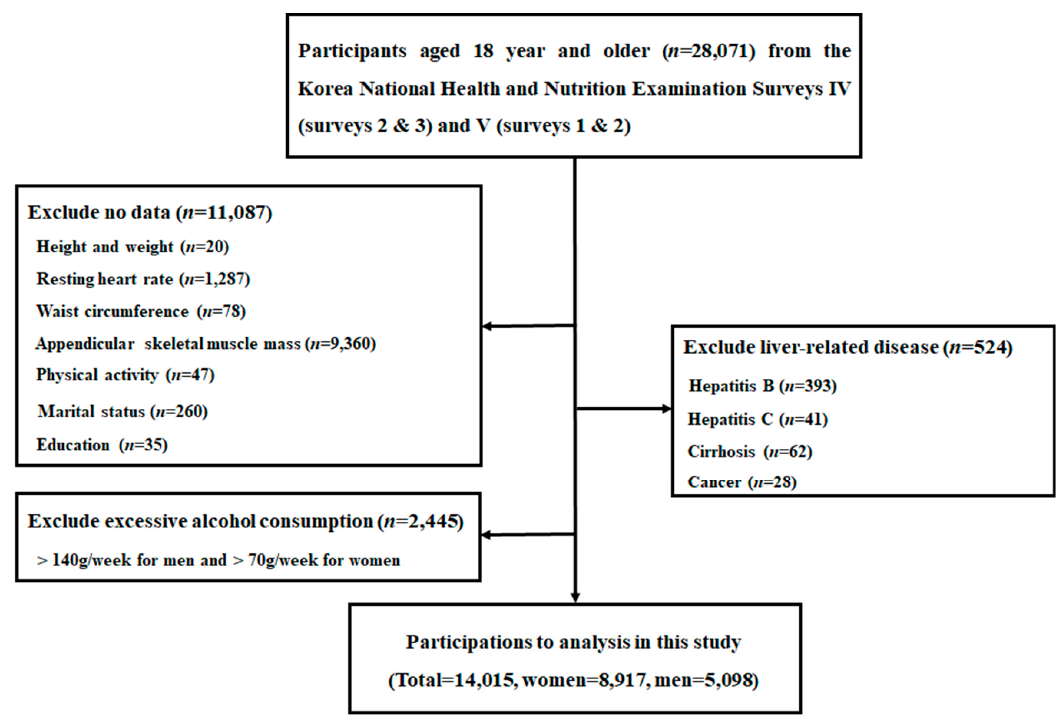
Figure 1. Flow chart of eligible participants in the study.